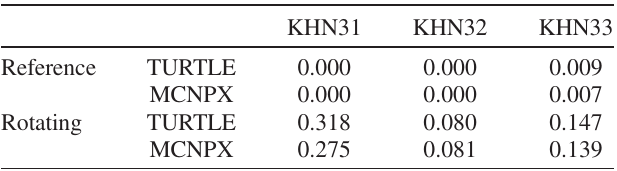
TABLE II. Losses in the collimators in % (the values are normalized to the total proton beam